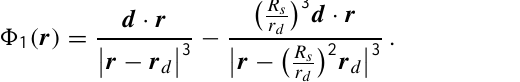
Fig. 1. Sketch of two different magnetic topologies: Null point (top) and bald patch